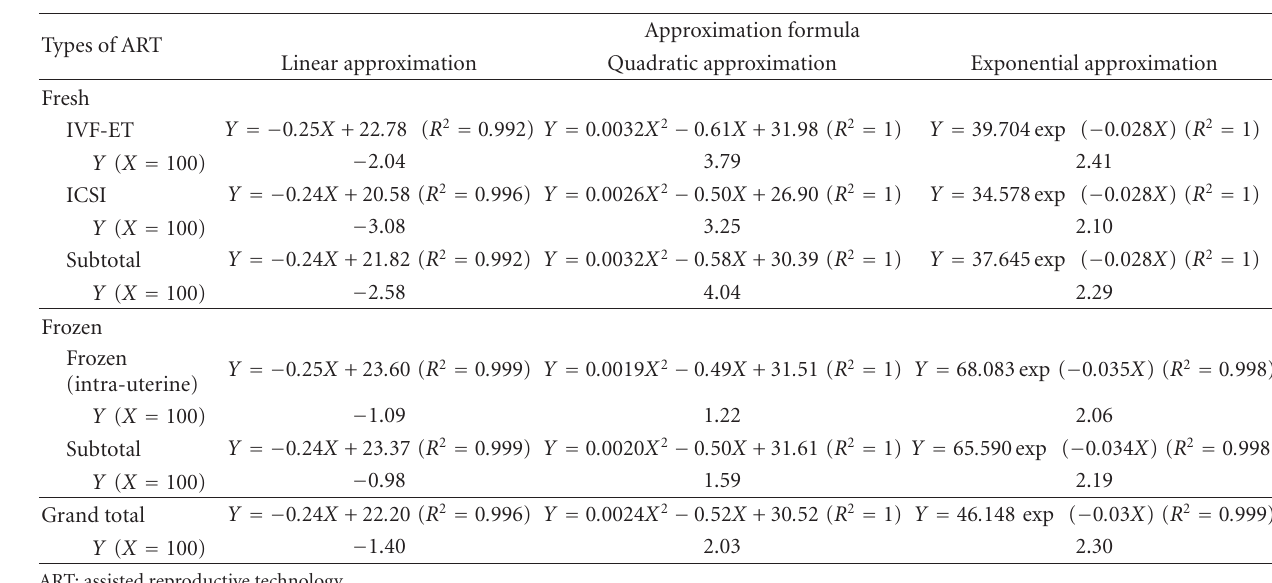
Table 2: Approximation formula with R 2